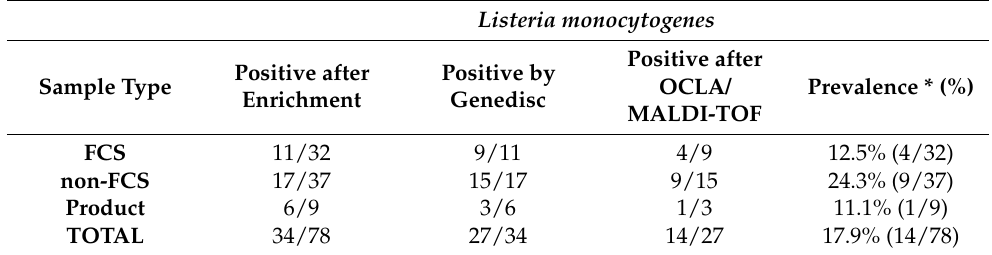
Table 2. Presence and prevalence of L. monocytogenes in the frozen vegetable processing plant.